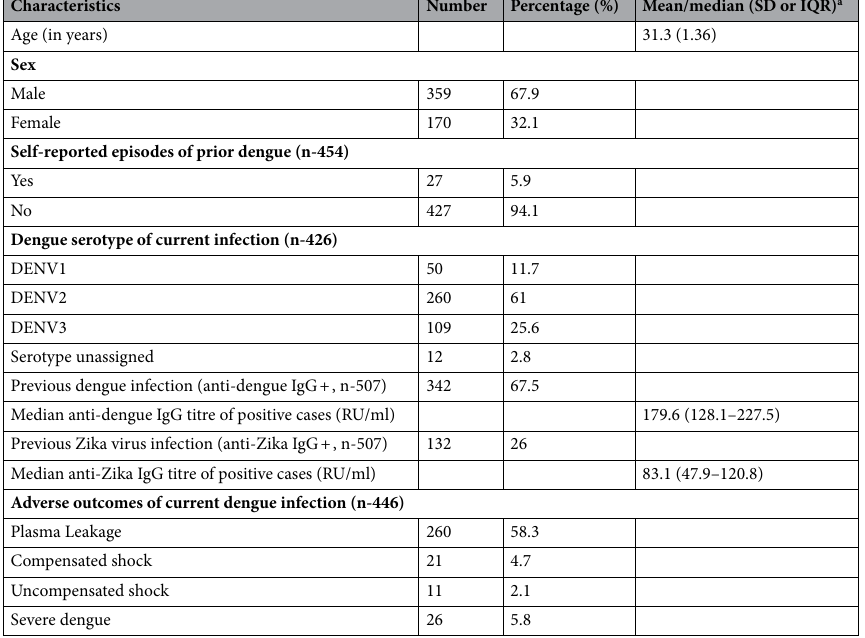
Table 1. Characteristics of patients. a SD standard deviation, IQR inter-quartile